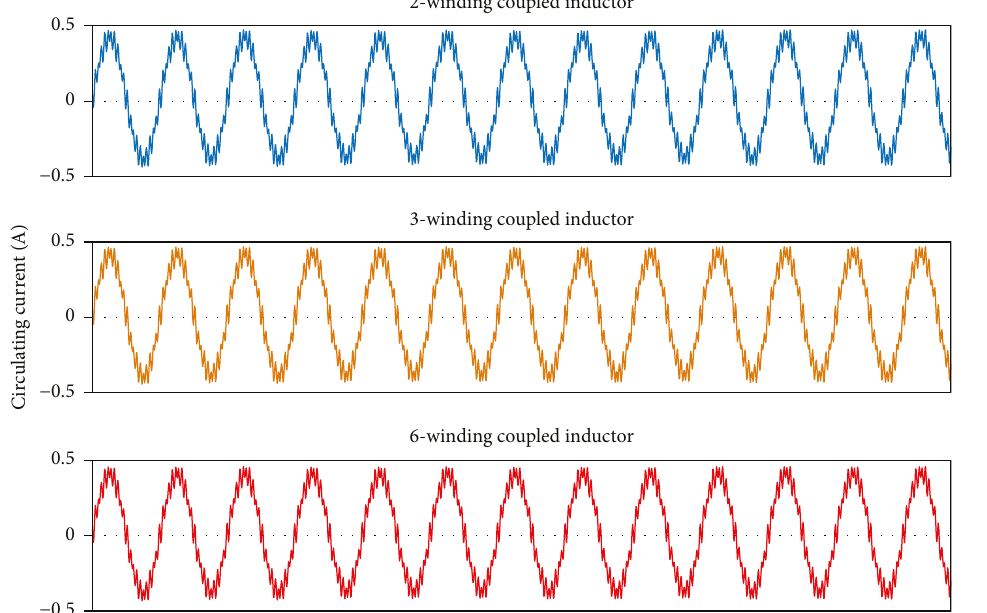
Figure 23: Circulating current inside the